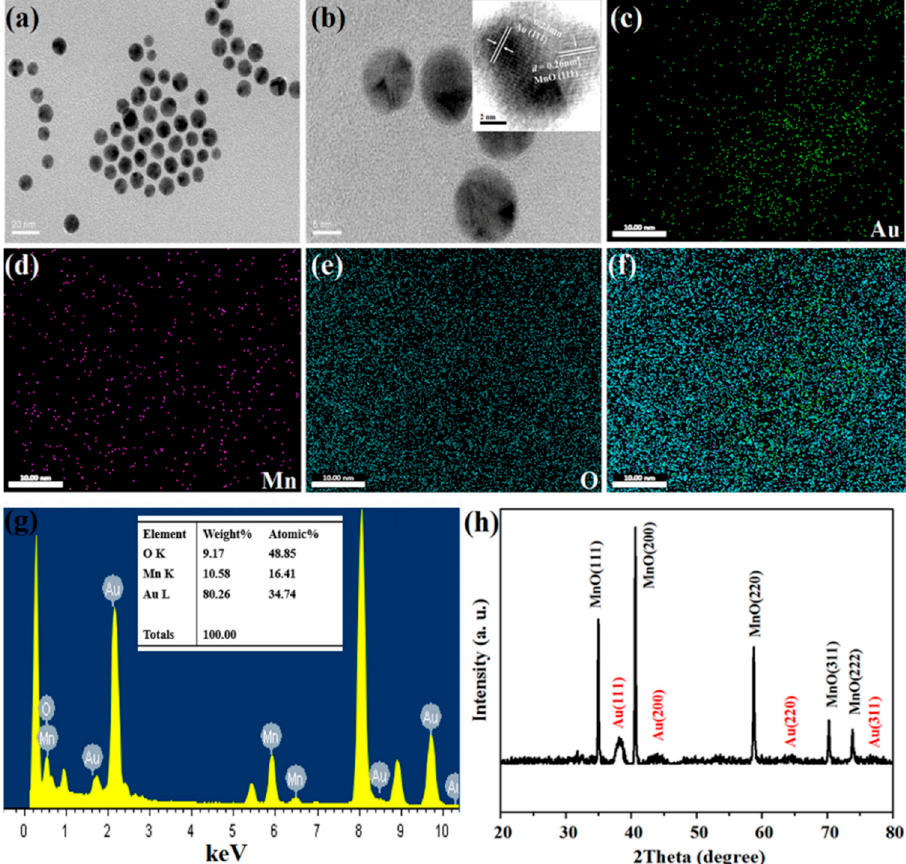
Figure 1. The structural characterization of Au-MnO HNPs. ( a , b ) low and high magnification TEM images (inset is a high resolution-TEM image of single hybrid nanoparticle), ( c – f ) STEM elemental color mapping images, ( g ) EDS spectra, and ( h ) the powder XRD pattern of prepared Au-MnO